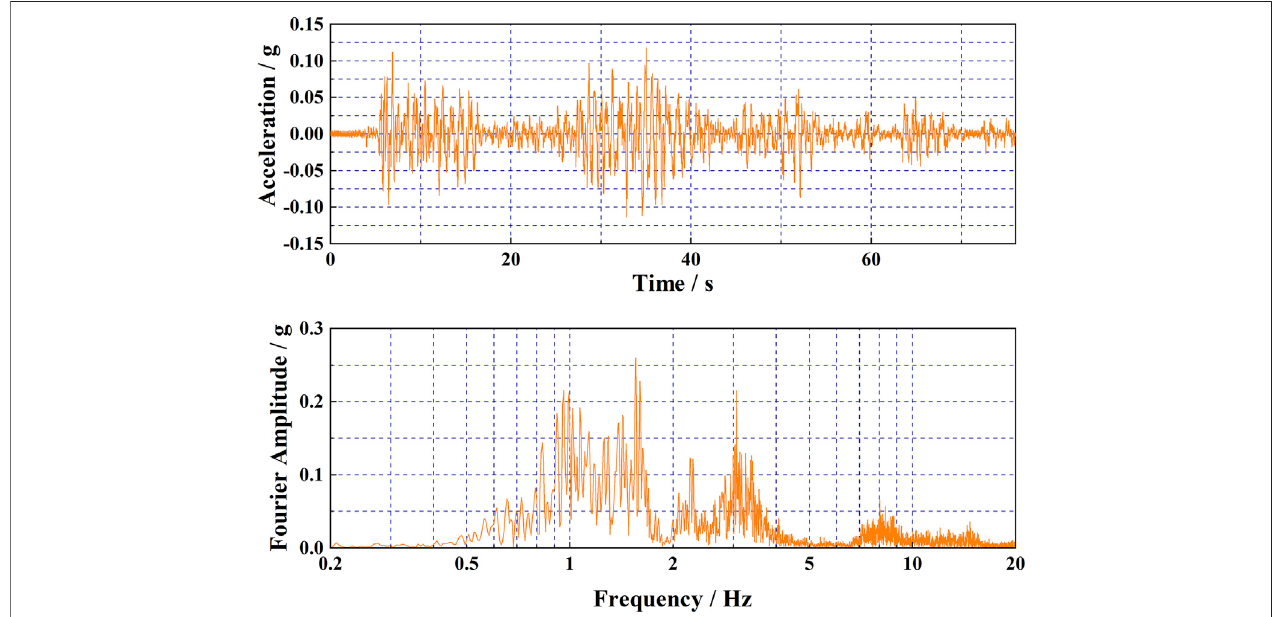
FIGURE 2 | Acceleration time history and Fourier spectrum of A0 during EQ1.